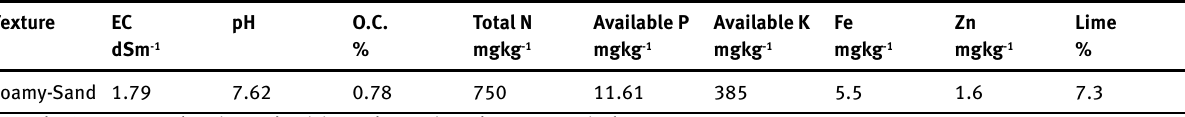
Table 1: Physiochemical characteristics of soil used in the experiment Texture